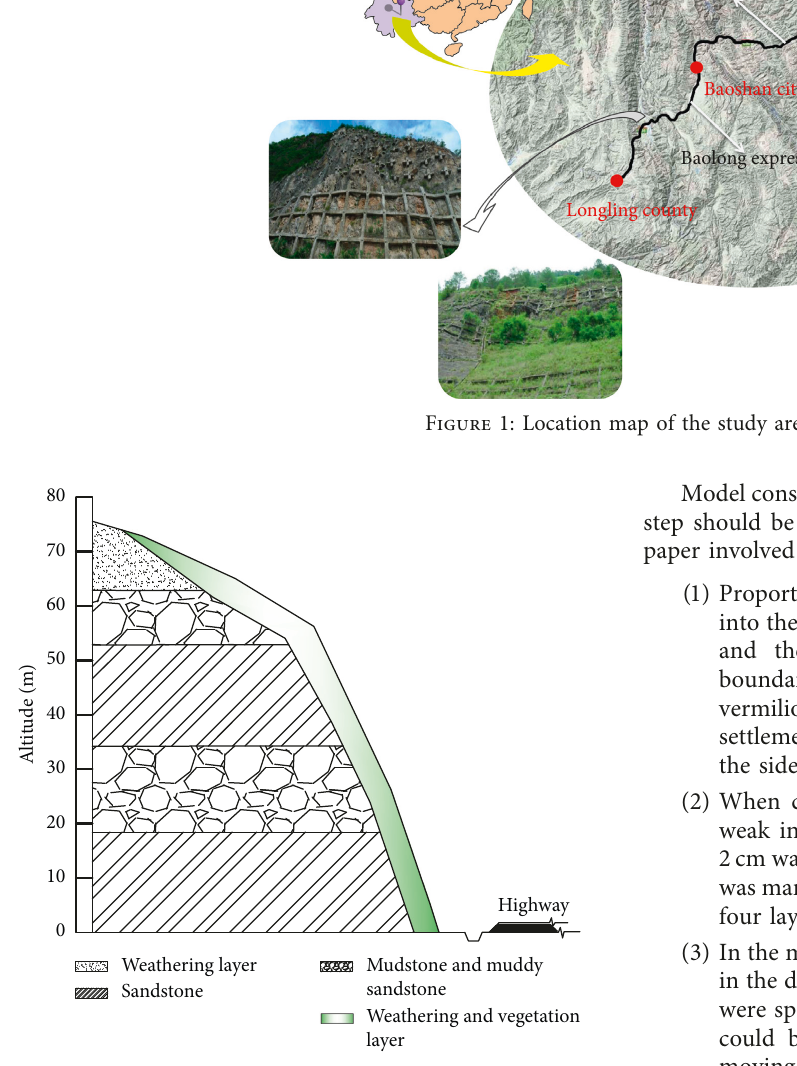
Figure 2: Typical slope